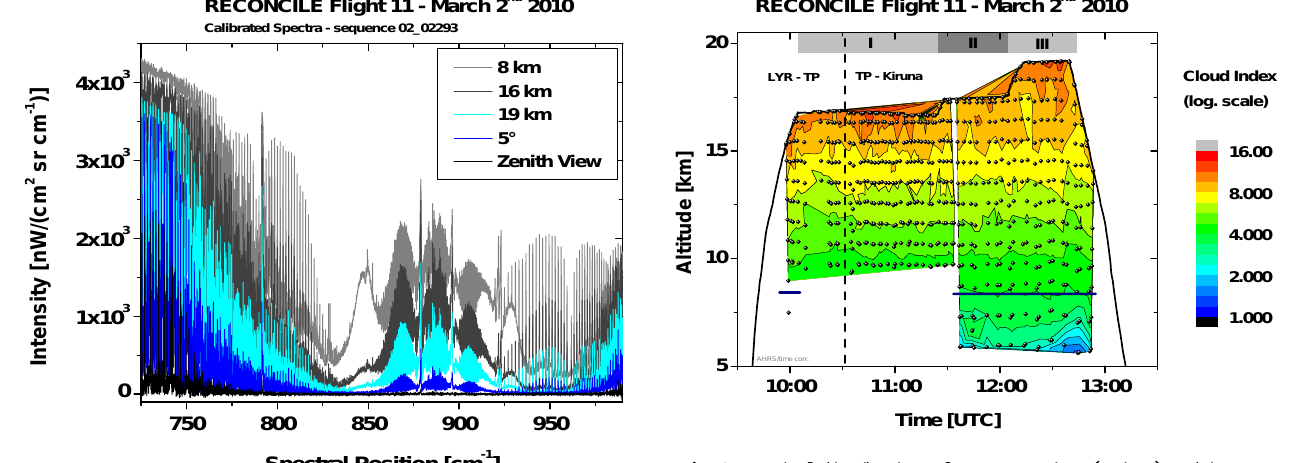
Fig. 6. Vertical distribution of tangent points (points) and interpo- lated cloud index (contour). Flight altitude of the Geophysica (solid black line) along flight track from Longyearbyen (LYR) via the turning point (TP, dashed black line) to Kiruna. The horizontal blue lines represent the approximate threshold for cloud index